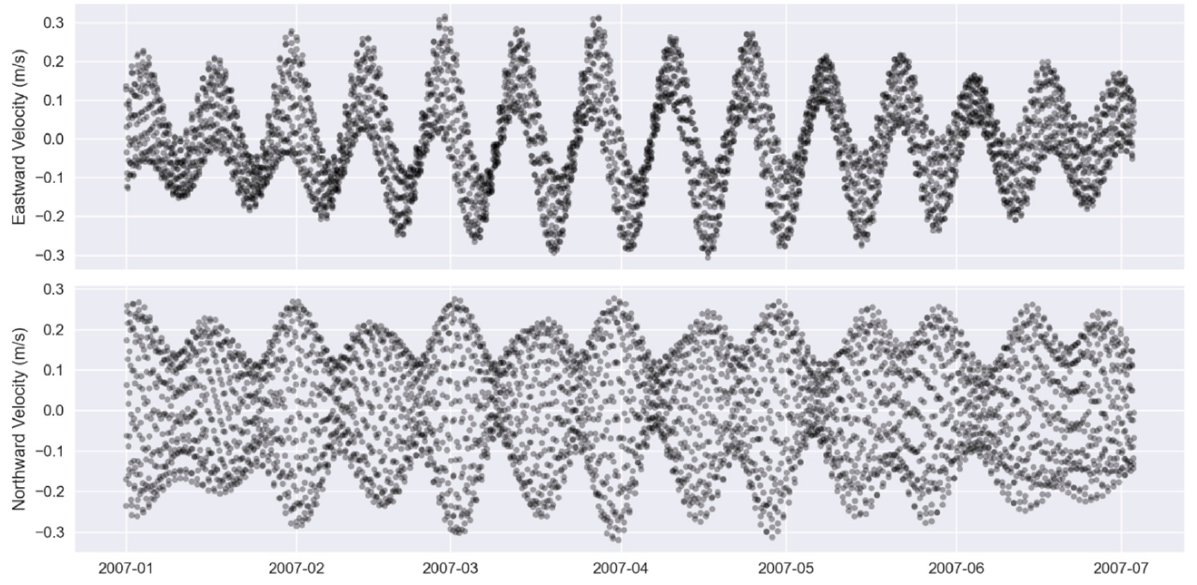
Figure 2. Time series of the hourly eastward and northward bottom currents at a CPZ vertex (triangle, Figure 1) of the northern reef. The currents are from [10].